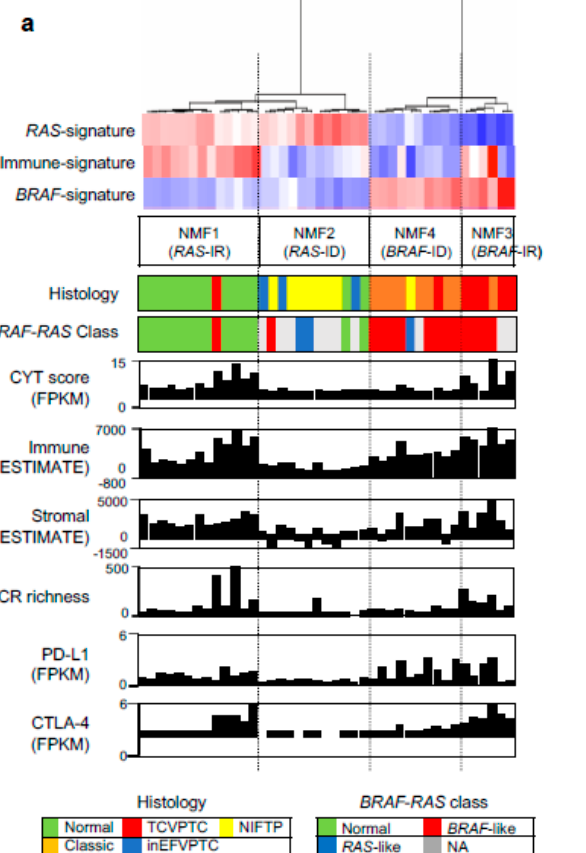
Figure 5. NMF clusters and immune features of CMC cohort. ( a ) Four NMF clusters determined by metagene projection of three metagene signatures for 41 thyroid profiles of CMC cohort. Five histological types and mutation-based BRAF -/ RAS -like classes are shown with corresponding legends below. Six immune-related features are shown, including CYT score, immune/stromal ESTIMATE scores, TCR richness, and expression levels of PD-L1 and CTLA-4; ( b ) A heatmap showing correlation levels between three metagene signatures and six immune features; ( c ) Abundance of 10 immune cell subsets ( p < 0.05; ANOVA test) with respect to four NMF